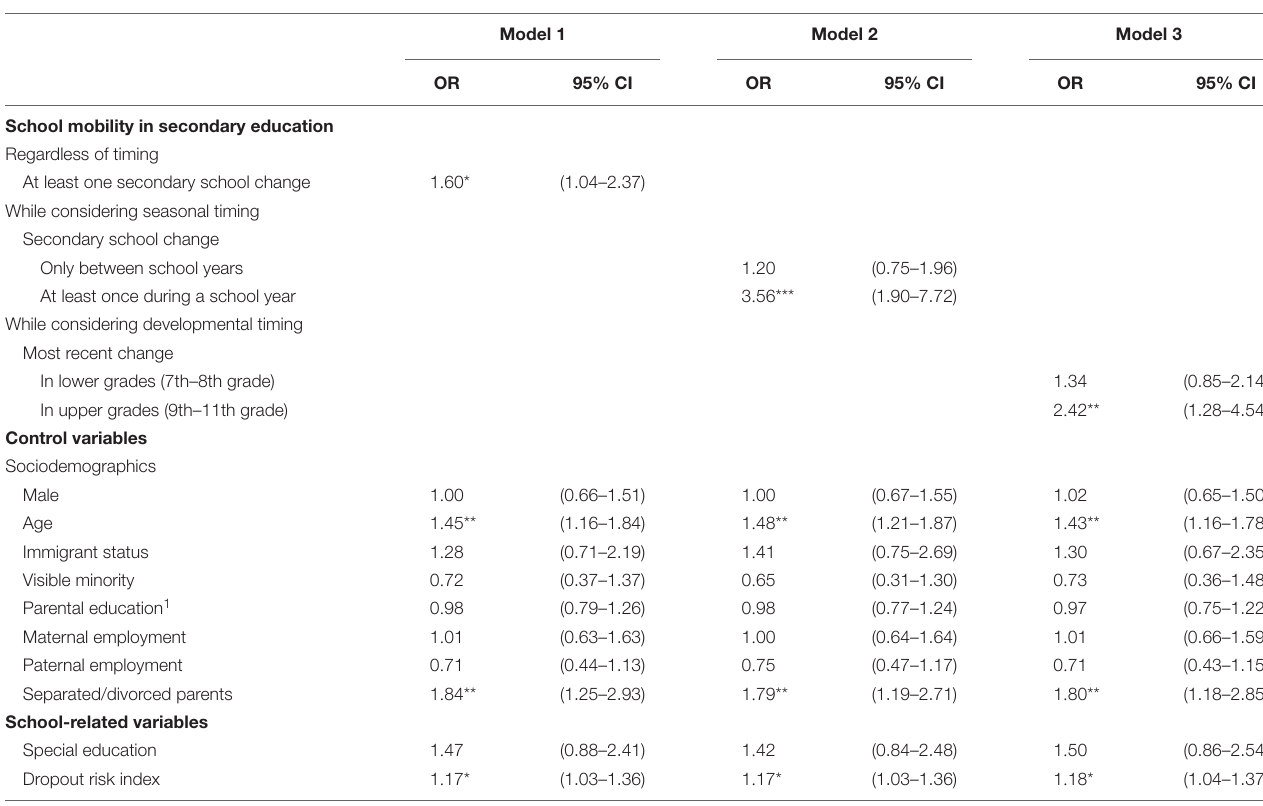
TABLE 3 | Multiple logistic regression models linking school mobility and dropout ( N =